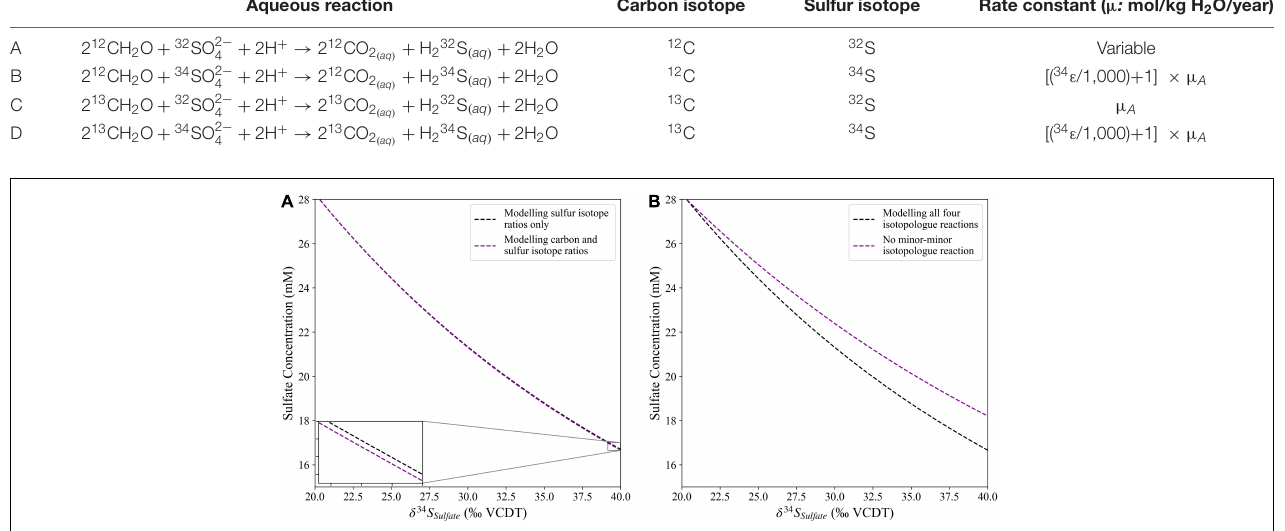
FIGURE 1 | Panel (A) shows the minimal impact that simultaneously modeling the carbon and sulfur isotope systems in CrunchTope has on the sulfur isotopic composition of sulfate during microbial sulfate reduction. Panel (B) displays the importance of modeling all combinations of the isotope specific aqueous reactions including the minor-minor isotopologue